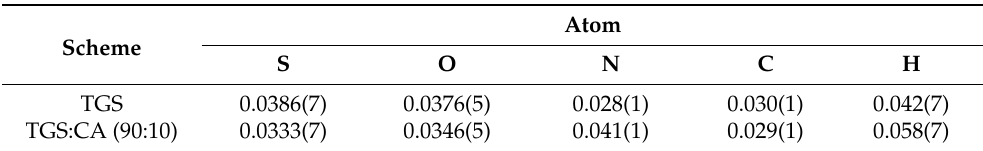
Table 5. Isotropic temperature factors U isoov (Å 2 ) common for each type of atom (e.s.d.s given in parentheses are not corrected for the coefficient m e.s.d. ).